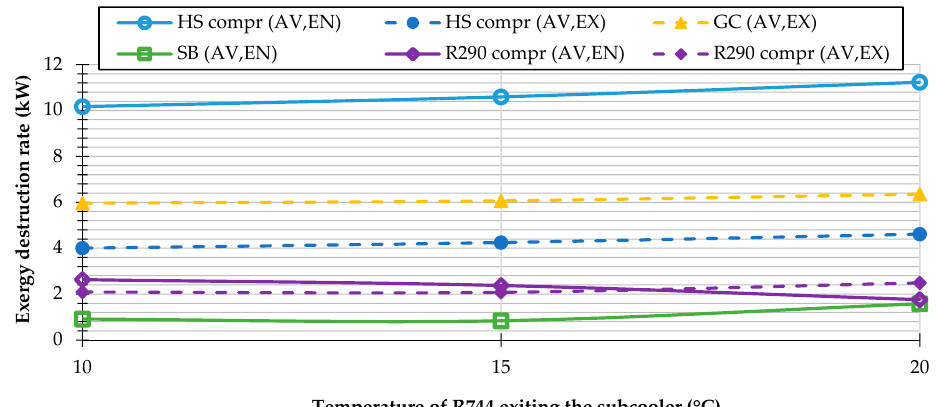
Figure 13. Effect of the temperature of R744 leaving the subcooler on the avoidable endogenous and exogenous exergy destruction rates of some selected components belonging to the investigated system at the outdoor temperature of 40 °C.